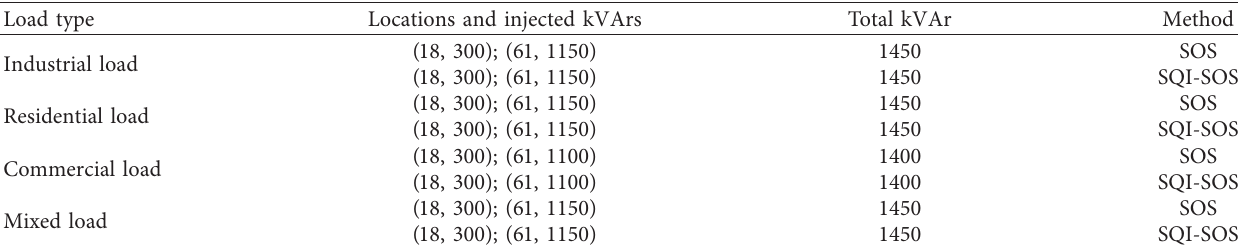
Figure 15: Comparison of lines power flow of the 69-bus system before and after compensation with the mixed load model. Table 13: Optimal locations and sizes of capacitors for the 69-bus system with different load models.